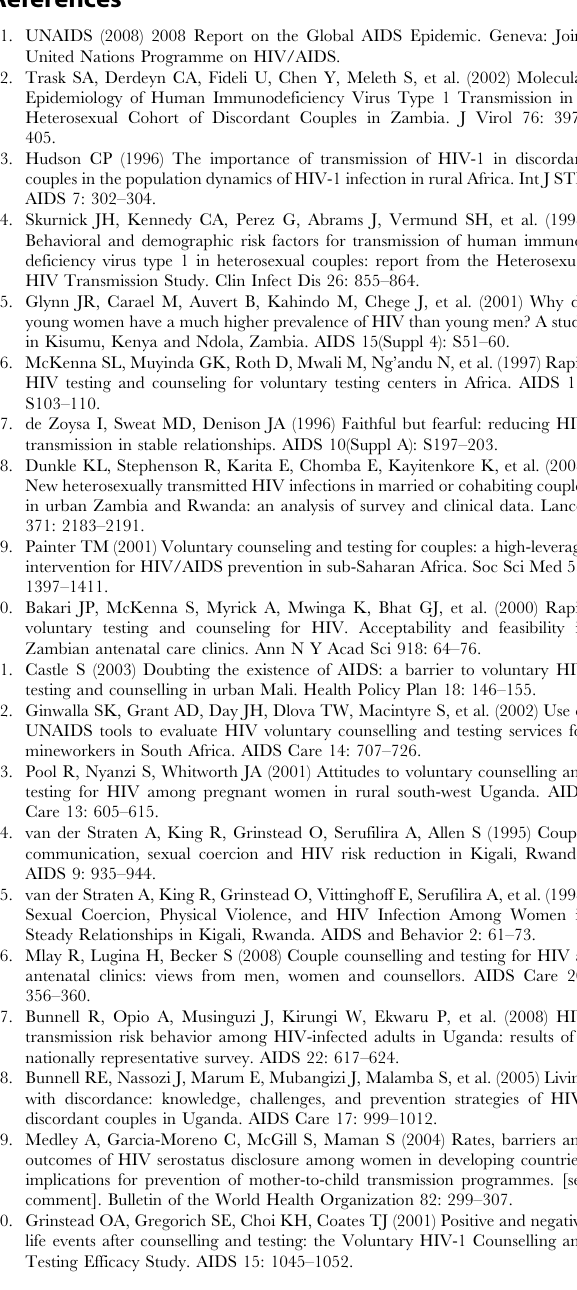
Table S1 Demographic Profile, Knowledge and Perceptions of Couples’ VCT a in Intervention and Control Neighborhoods. Table S2 Knowledge and Perceptions of Couples’ VCT a by Cohabitation, Education, and Gender among Kigali Respondents.